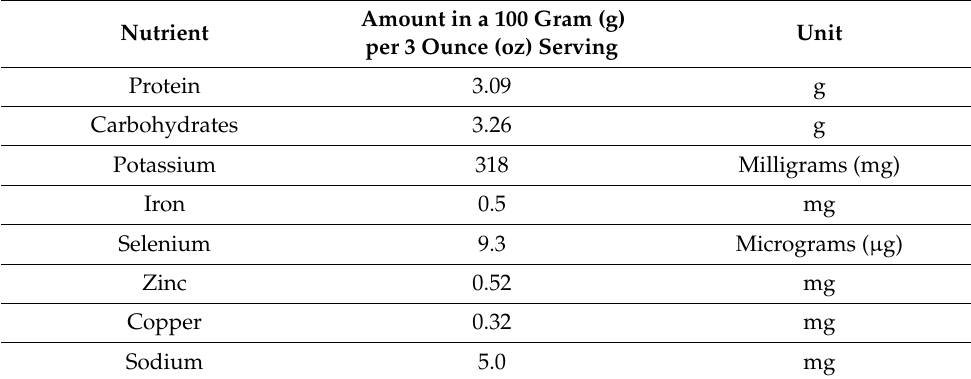
Table 1. White Button Mushroom Concentrations Sample (USDA, 2018). Amount in a 100 Gram (g) Unit Nutrient per 3 Ounce (oz) Serving Protein 3.09 g Carbohydrates 3.26 g Potassium 318 Milligrams (mg) Iron 0.5 mg Selenium